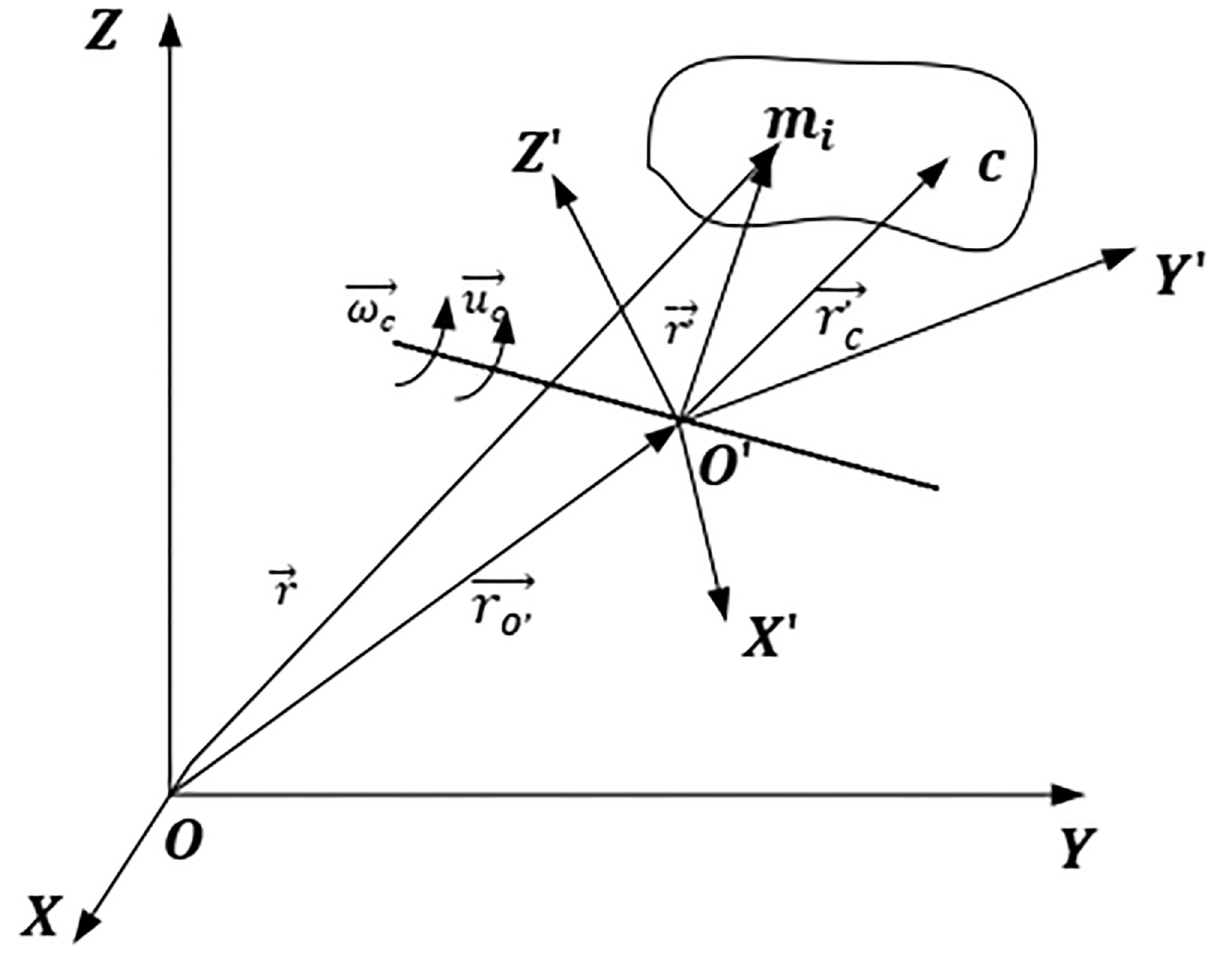
Fig 1. Momentum theorem for mass points in general non-inertial